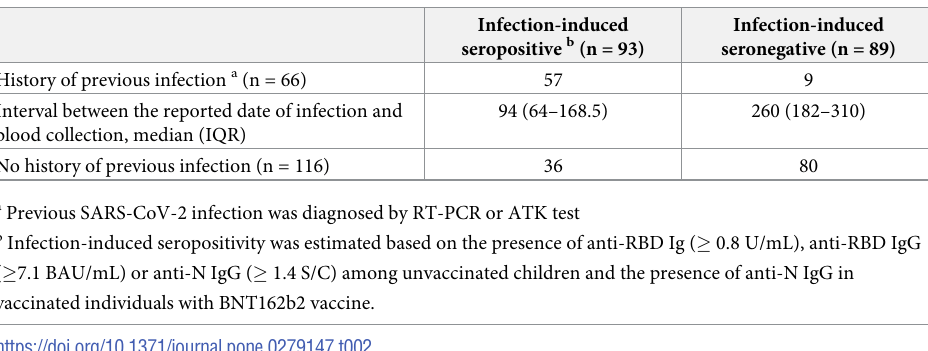
Seroprevalence induced by infection, vaccination, and hybrid immunity We further estimated the overall seroprevalence induced by natural infection, vaccination, and hybrid immunity based on the seropositivity of anti-RBD antibodies (Fig 3). Regarding the vaccine implementation in children, the seropositivity of anti-RBD antibodies was 77.1% (155/ 201) between January and December 2022, which increased by March 2022 and was > 80% (95%CI: 85–96%) from April 2022.